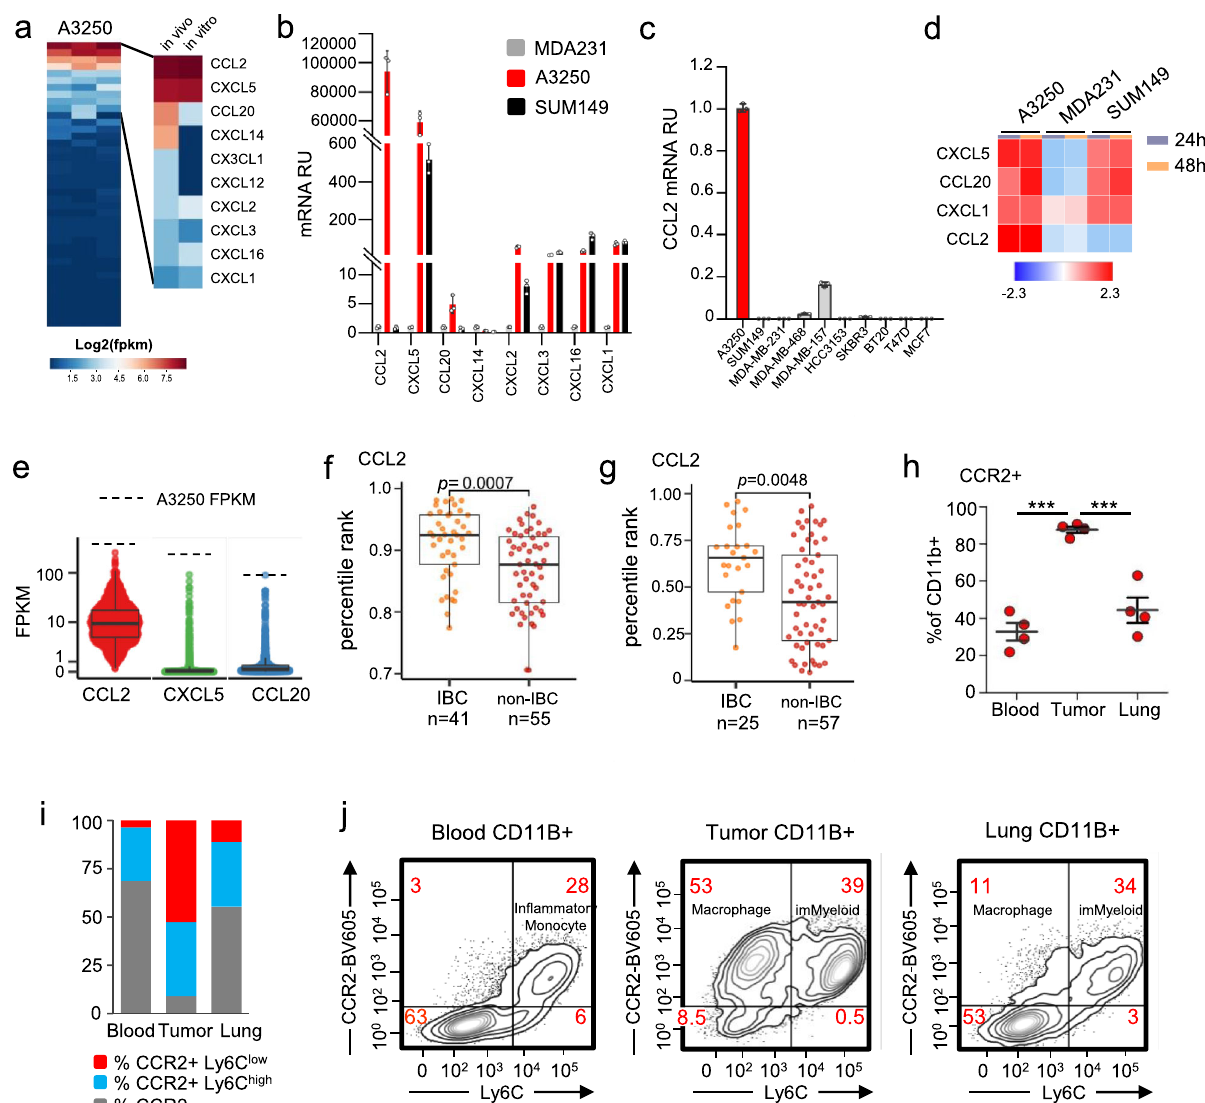
Fig. 7 Chemokine expression in A3250 and in human IBC. a mRNA-Seq analysis of human chemokines in A3250 tumors in vivo and cells in vitro, shown as log2(FPKM). b qPCR for chemokines as indicated in A3250, SUM149 and MDA-MB-231 cells in vitro. n = 3 biologically independent samples. Data are presented as mean values ± SD. Two independent experiments were performed. c qPCR for CCL2 expression in A3250 cells in vitro compared to the SUM149 and eight non-IBC cell lines. n = 3 biologically independent samples. Data are presented as mean values ± SD. Two independent experiments were performed. RU = relative units. d Chemokines in supernatants of cells as indicated, detected with Olink proteomics. Select chemokines are shown, that were expressed by mRNA and present in Olink In fl ammation panel. Heatmap indicates matrix values, data scaled by row. e Boxplot showing the distribution of FPKM values for CCL2, CXCL5 , and CCL20 chemokines in 1222 TCGA breast cancer samples. Each point represents an individual sample. Dotted line indicates average FPKM for the A3250 tumor ( n = 3). CCL2 expression in IBCs and non-IBCs by analysis of human microarray datasets E- MTAB-1006 24 ( f ) and GSE22597 26 ( g ), measured as the percentile rank of signal intensity for the maximally expressed probe for CCL2 . Box extends to 25th and 75th percentiles, whiskers to the 10 – 90 percentile and black line denotes the median. The signi fi cance of the difference in distributions of percentile ranks in IBC vs non-IBC samples was assessed using Wilcoxon rank sum test. h – j Expression of CCR2 on myeloid cell subsets in A3250 tumors,